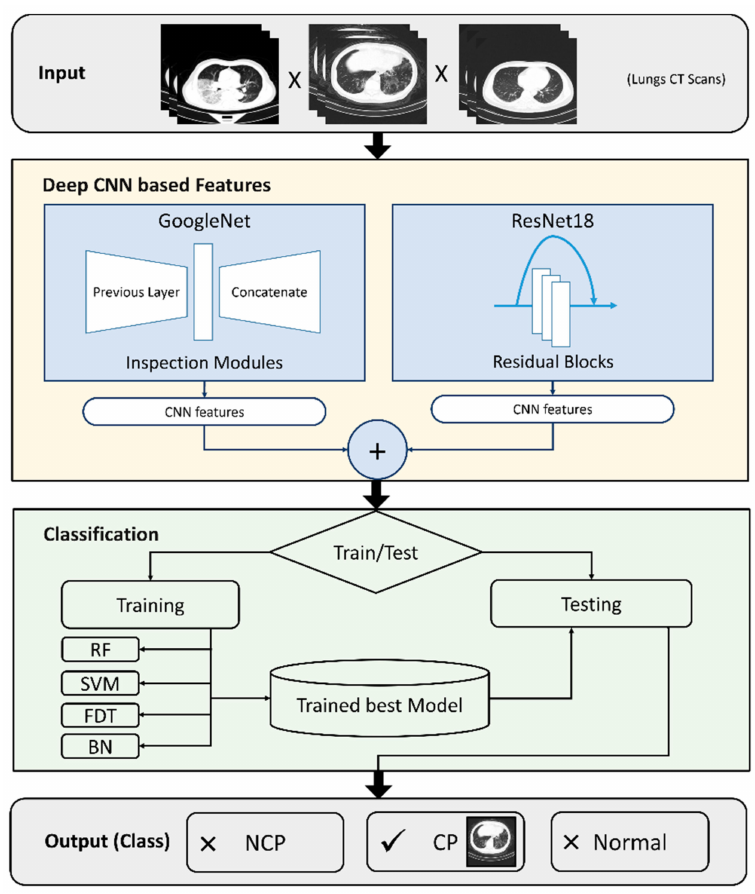
Figure 1. Workflow of the proposed